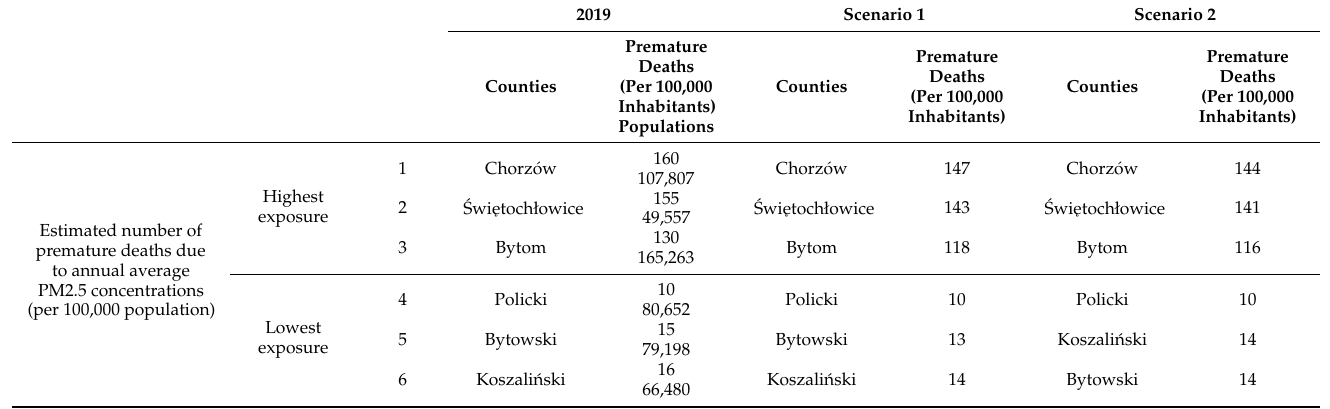
Table 2. Counties with the highest estimated number of premature deaths due to annual average PM2.5 concentrations (per 100,000 population) in 2019 and based on scenario 1 and scenario 2 forecasts. The counties are shown on the map (Figure 5) numbered from 1 to